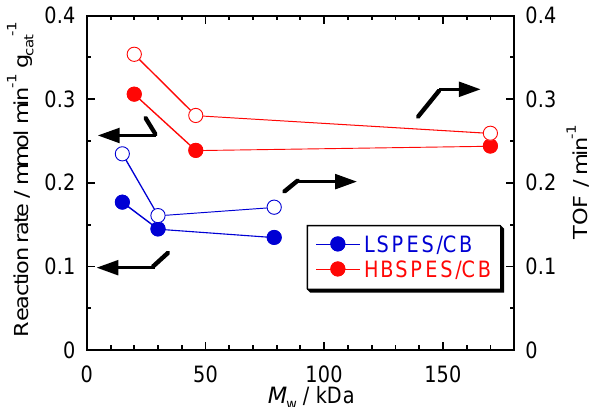
Figure 4. Normalized reaction rates and apparent turnover frequencies of homogeneous catalytic reactions for the esterification of 1-butanol (32 mmol) and acetic acid (1.8 mmol) at 65 ◦ C for 0.5 h [10]. The recyclability of HBSPES/CB was tested by filtering the reaction mixture and reusing the catalyst powder, and the results are shown in Figure 5 [9]. Although the collection yield of HBSPES/CB was not 100%, over 90% HBSPES/CB was successfully collected, even after five runs. Moreover, the catalytic activity of HBSPES/CB appeared to be fairly stable, so it can be concluded that the stability of HBSPES/CB is quite promising.